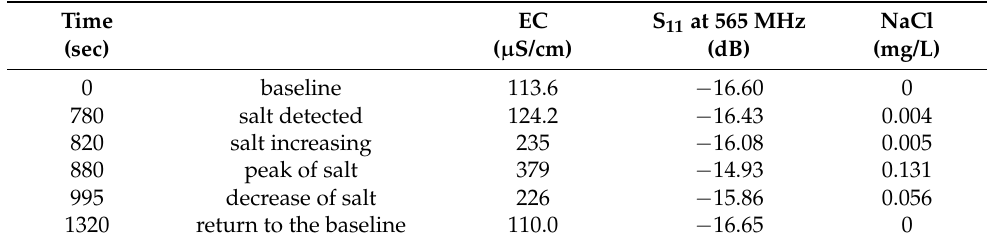
Table 5. Variation in EC and S 11 signal by time due to change in salt in situ and in real time and the return to the baseline spectrum. NaCl was successively measured by applying conversion